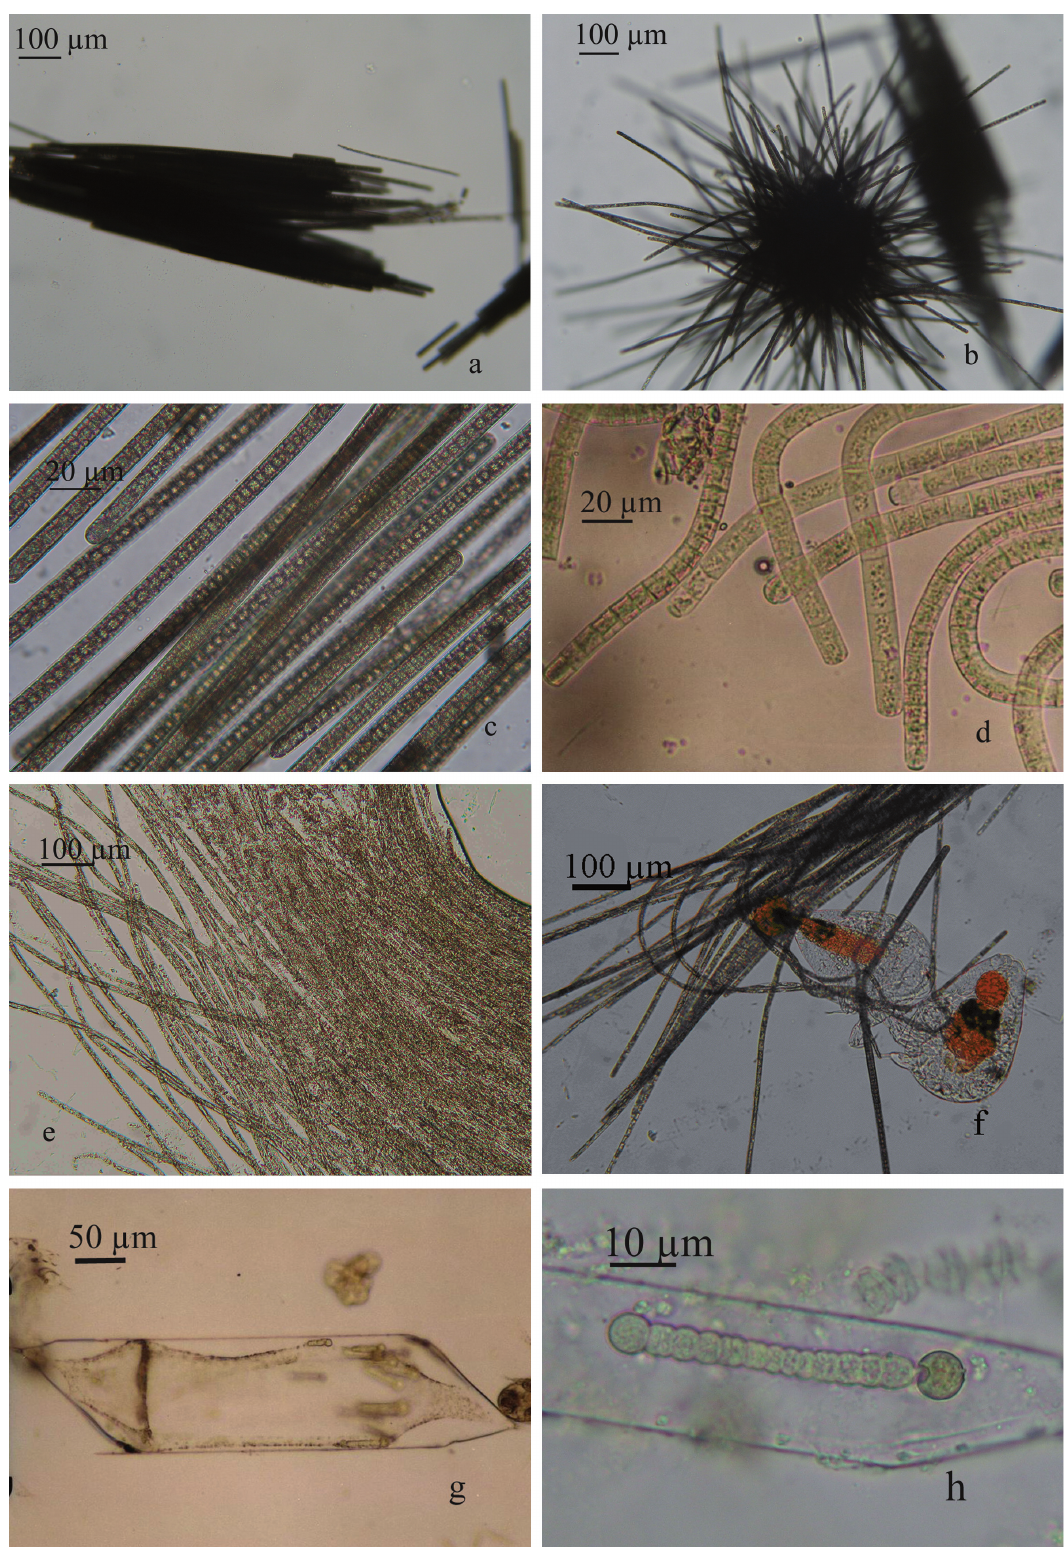
Fig . 2. – Photomicrographs of the main pelagic nitrogen fixing cyanobacteria detected in sanya Bay, south China sea. a. Trichodesmium erythraeum colony (tuft); b. Trichodesmium thiebautii colony (puff); c. Trichodesmium erythraeum filaments; d. Trichodesmium thiebautii filaments; e. Trichodesmium autolysis; f. Trichodesmium grazed by zooplanktons; g . Richelia (endosymbiont in the diatom Rhizosolenia ); h. Morphology of Richelia